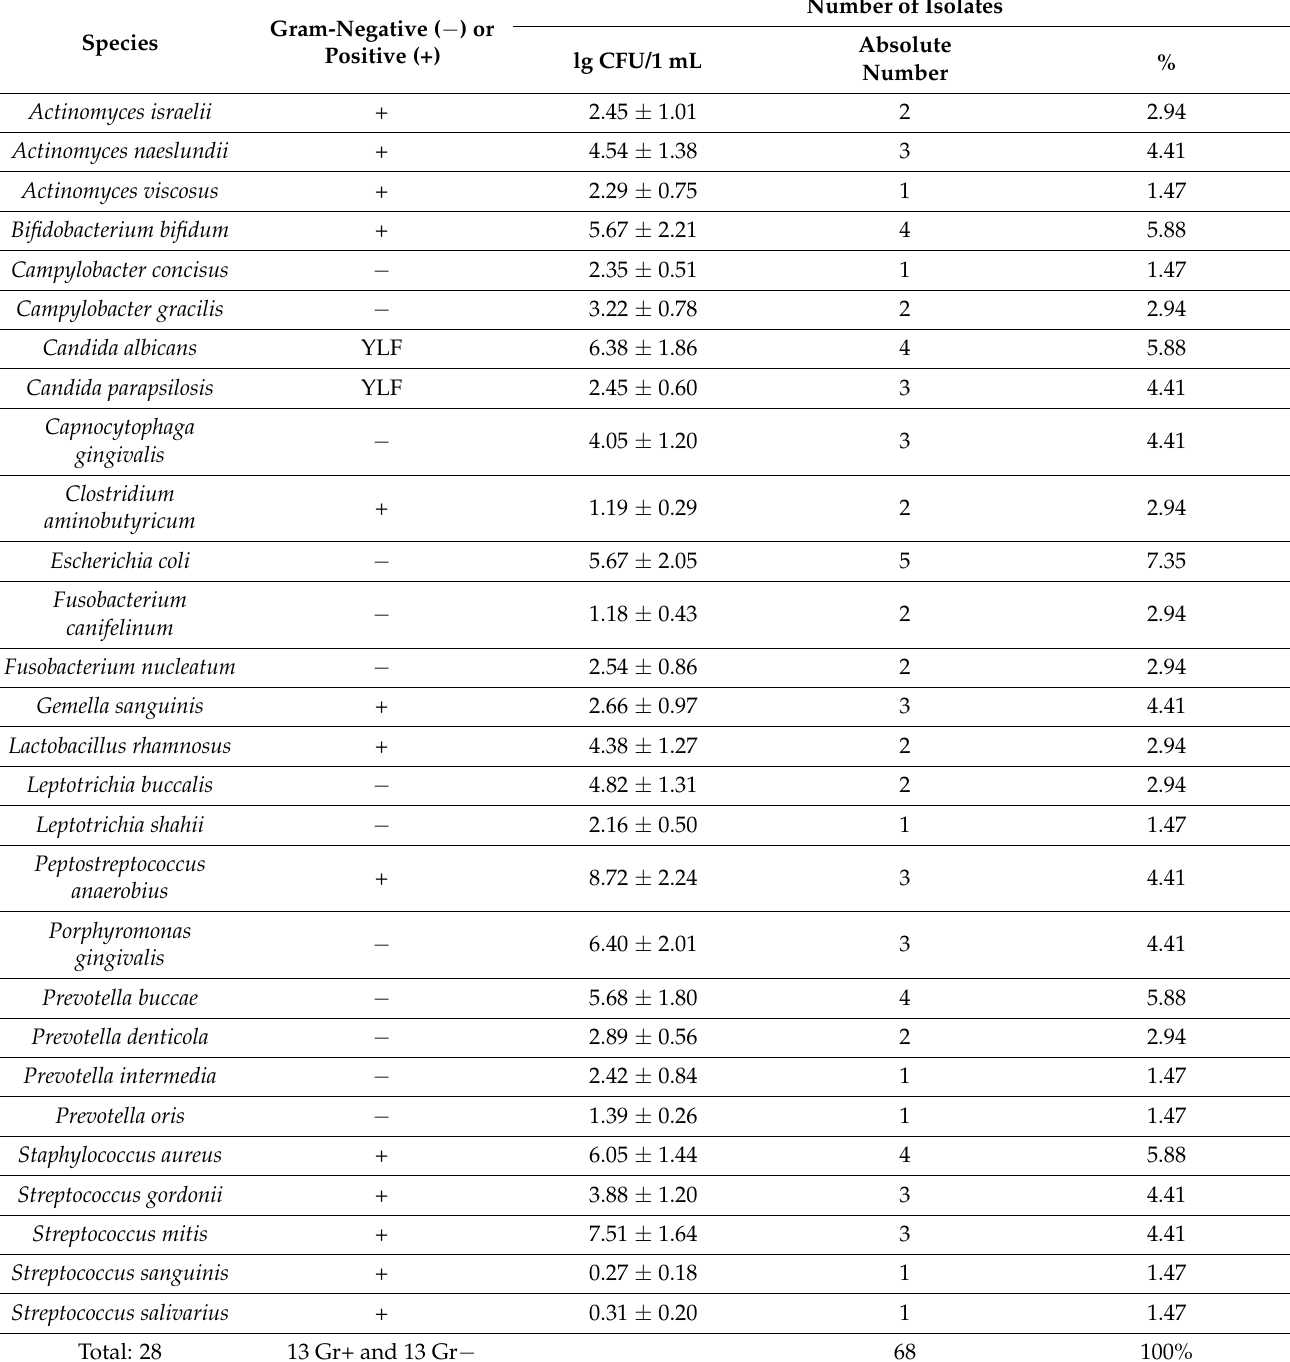
Table 1. Groups of microorganisms according to the degree of dominance on